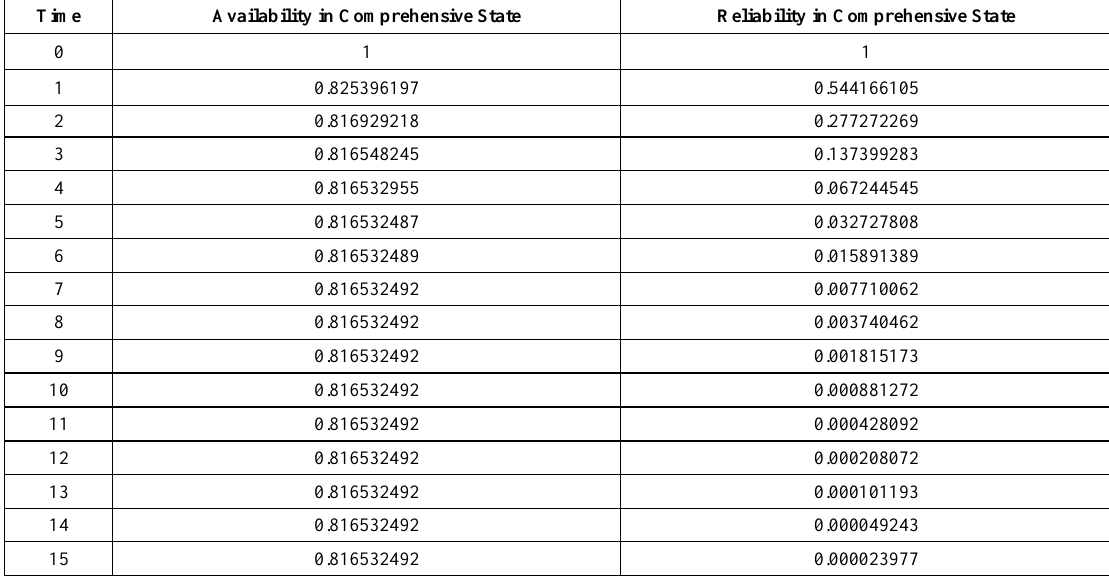
Table 2. Availability and Reliability of system in Comprehensive